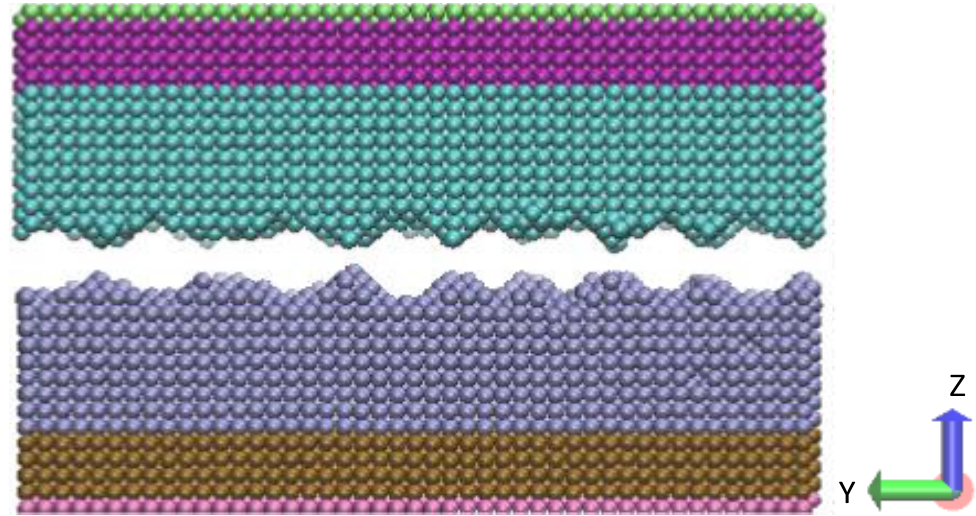
Figure 7. A side view of the particle model with 16 nanoparticles under the normal load of 1.0 GPa during sliding at 4000 ps. Only the upper and lower walls are shown to illustrate the plastic deformation during the sliding process.